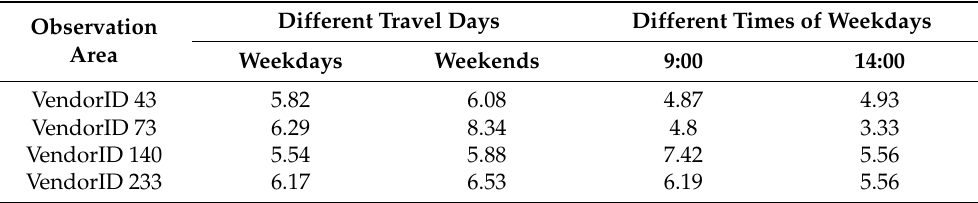
Table 2. RMSE performance of HDGCN modeling results during different time periods.